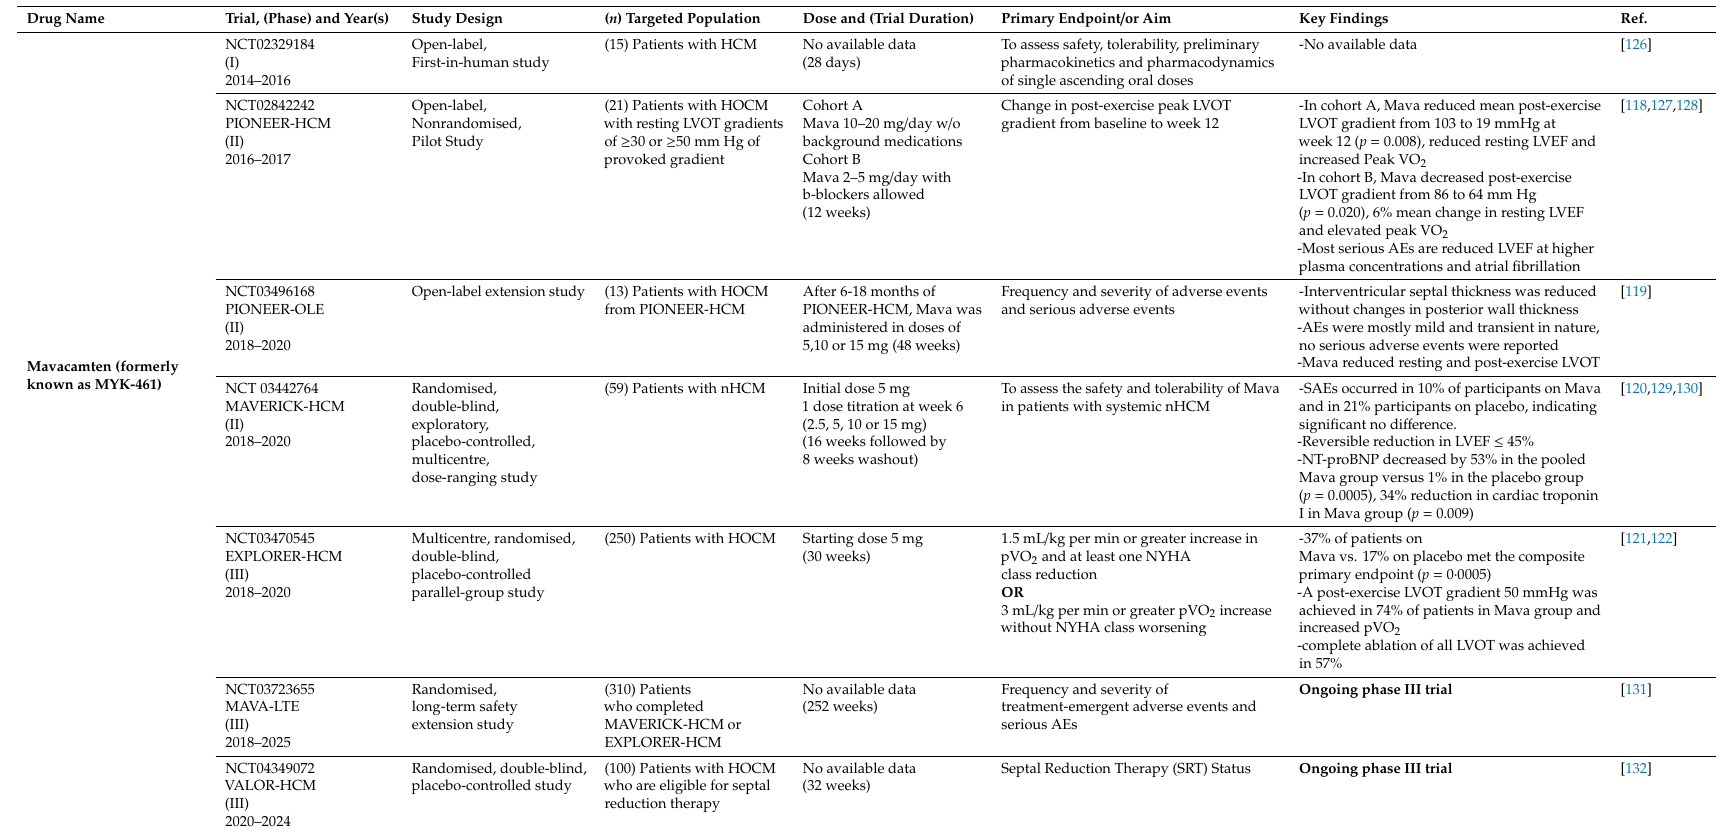
Table 4. Overview of reported clinical trials on cardiac myosin